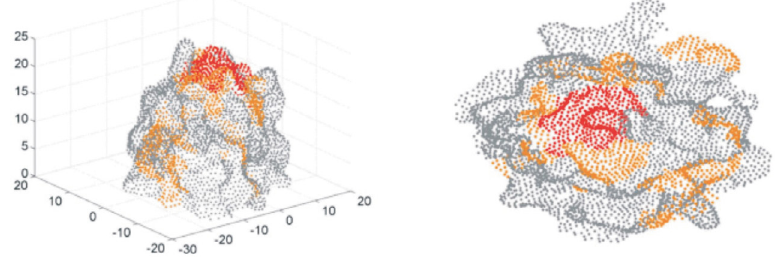
Fig. 20. Maps showing the complex shapes of proteins (H. Yang, R. Qureshi, A. Sacan